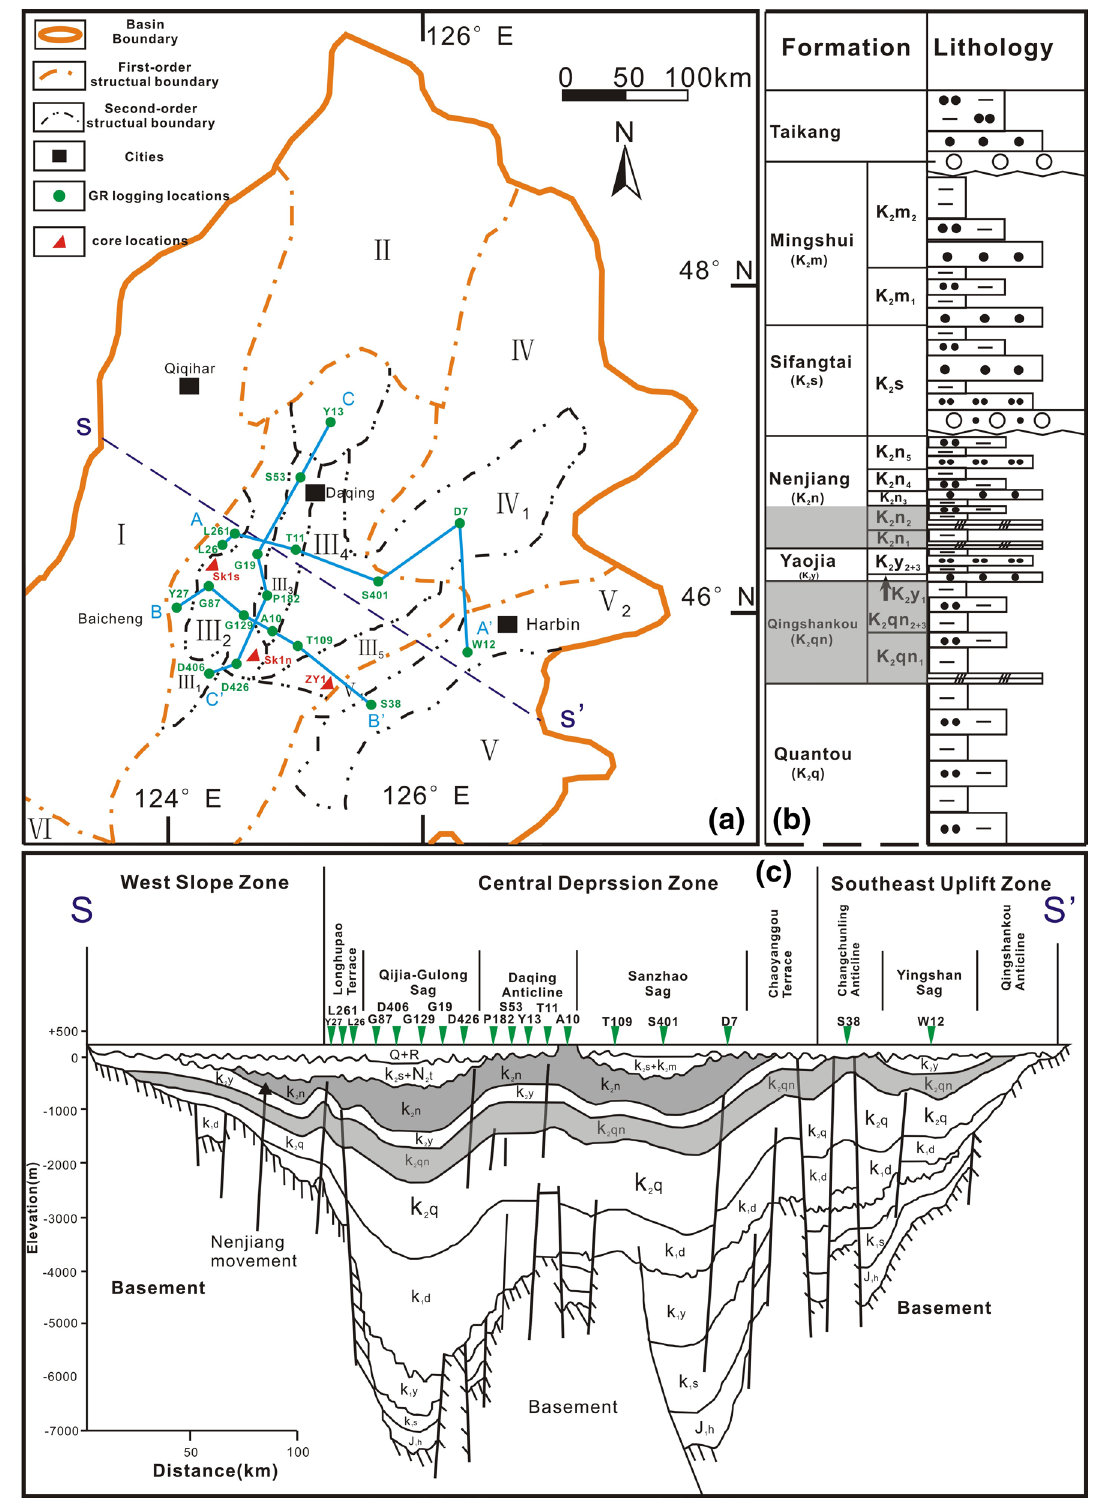
Figure 4. Map of structural units of the Songliao Basin with locations of natural gamma-ray logs ( a ). I, western slope zone; II, northern plunge zone; III, central depression zone; III1, Longhupao-Honggang Terrace; III2, Qijia-Gulong Sag; III3, Daqing Anticline; III4Sanzhao Sag; III5, Heiyupao Sag; IV, northeastern uplift zone; IV3, Suihua Sag; V, southeastern uplift zone; V1, Binxian-Wangfu Sag; VI, southwestern uplift zone. Lithostratigraphy of the Upper Cretaceous Songliao Basin ( b ). Stratigraphic cross section (S–S ′ ) through the basin ( c ). Modified from Yang et al., 2018 7